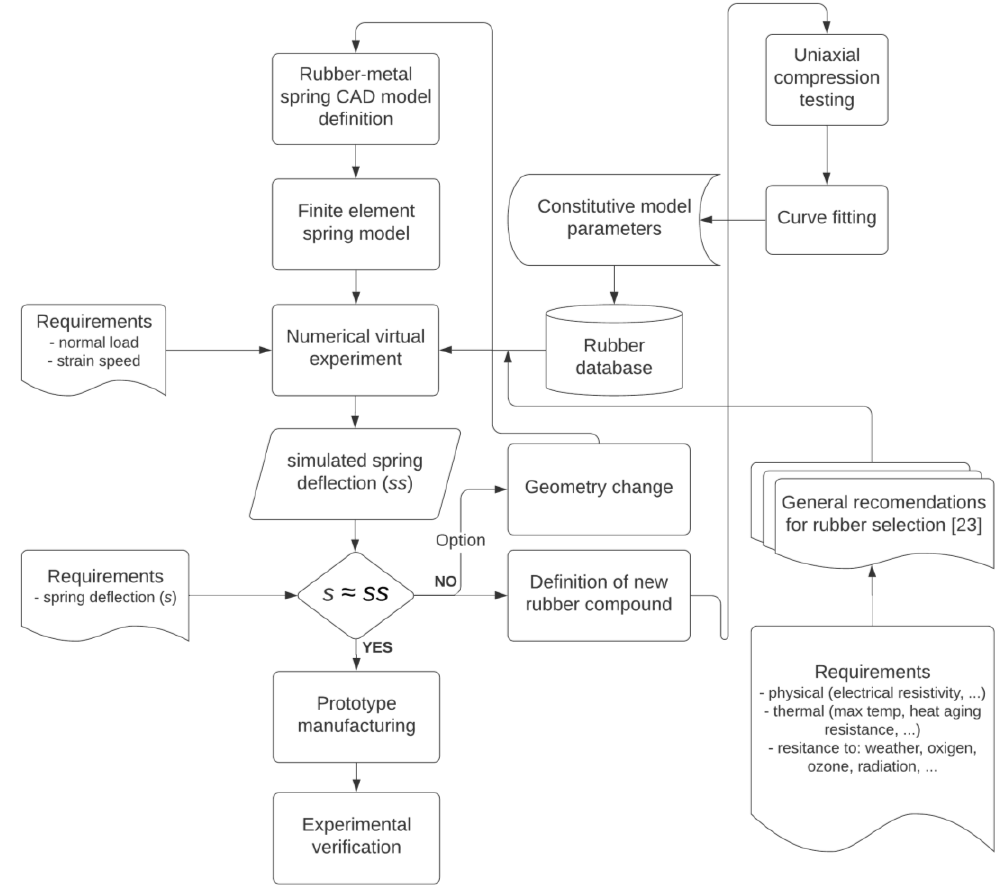
Figure 1. Procedure for selection of rubber compound in rubber-metal vibration isolators.